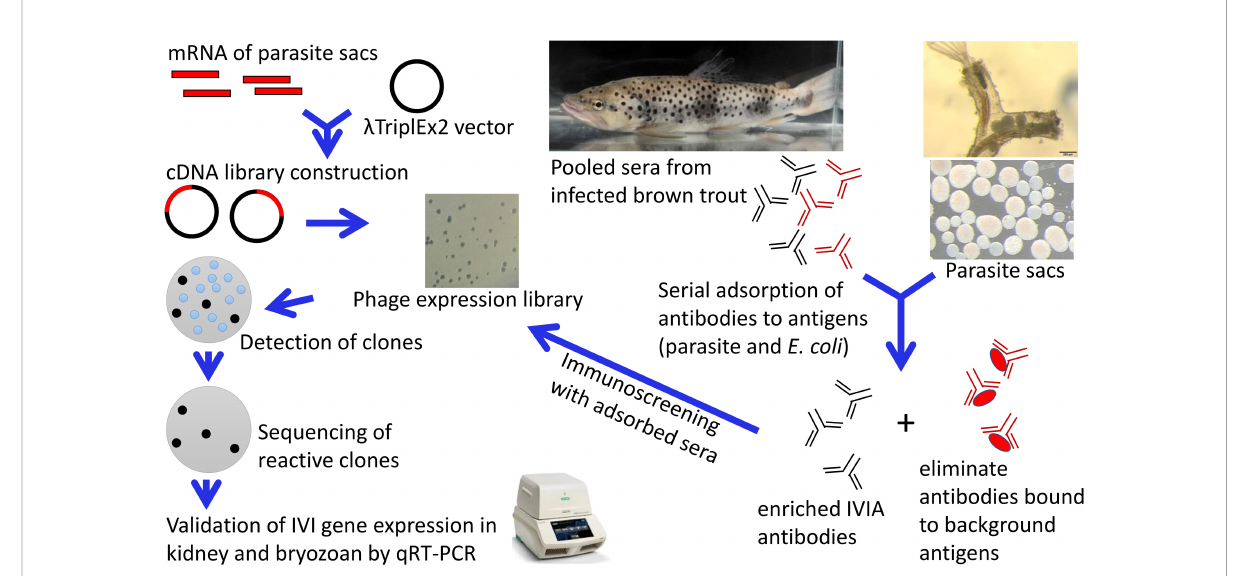
FIGURE 1 In vivo -induced antigen technology applied to Tetracapsuloides bryosalmonae . An expression library of T. bryosalmonae was constructed into the l TriplEx2 vector. Adsorption of pooled sera were performed to remove antibodies against three forms of parasite sacs and E. coli XL1-Blue antigens (native, ultrasonic, and heat-denatured). This process eliminates antibodies in the sera that react to antigens constitutively expressed by T. bryosalmonae in the bryozoan body cavity and eliminates background that may arise from the E. coli . Immunoscreening of expression cDNA library was performed with adsorbed pooled sera. Positive clones were sequenced, subcloned and validated in infected kidney of brown trout and infected bryozoan by